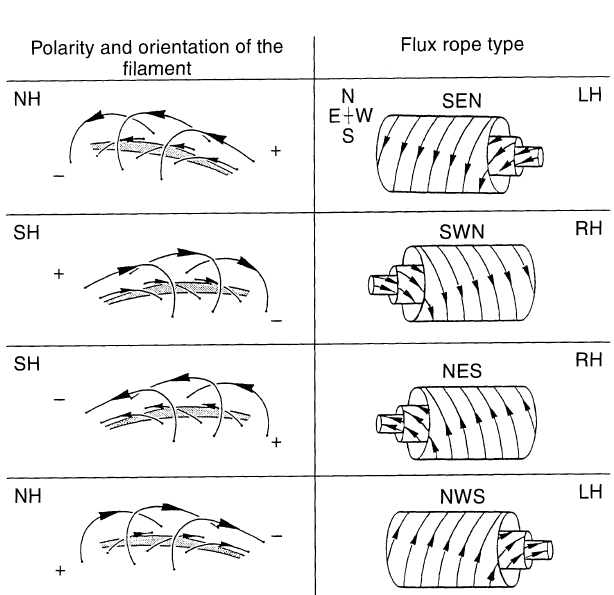
Fig. 17. Inferred magnetic structure of filaments in the Sun’s northern and southern hemispheres ( NH, SH ) and that of associated MCs in interplanetary space (adapted from Bothmer and Schwenn, 1994). The abbreviations for the magnetic field structures have been chosen in analogy to the di(cid:128)erent flux tube types of MCs presented in Table 2. LH (left-handed) and RH (right-handed) denote the corresponding